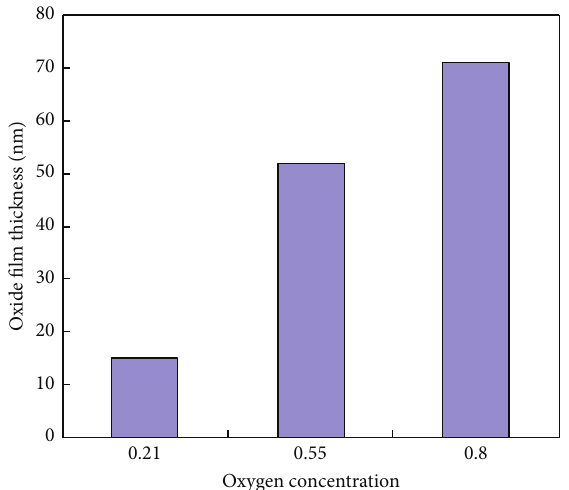
Figure 5: Surface oxide film thickness with respect to oxygen con- centration during